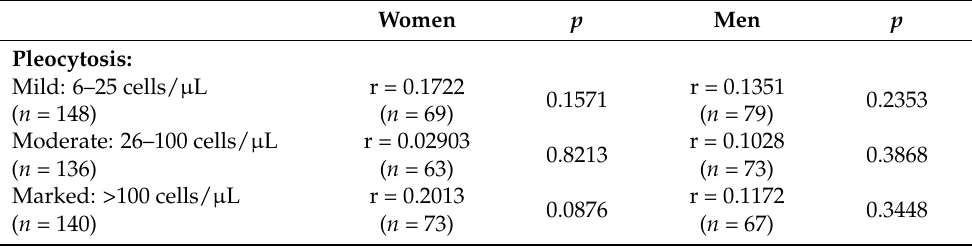
Table 4. Spearman correlation analysis for cerebrospinal fluid (CSF) total protein levels and number of CSF white blood cells in a cohort of 424 neurological patients grouped by pleocytosis